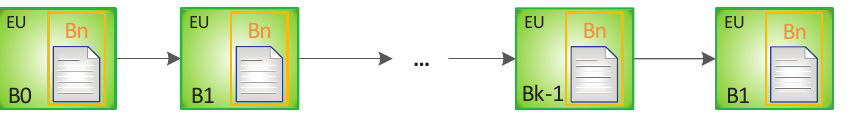
Figure 6. Overall structure of the nested